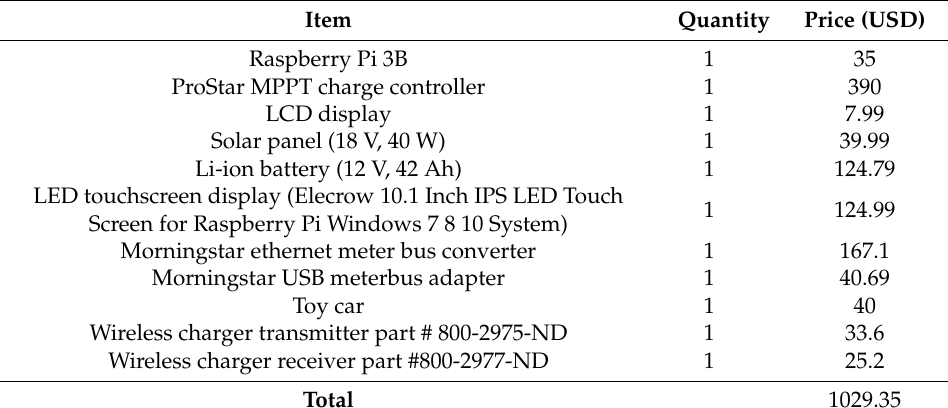
Figure 3. Hardware Schematics. Table 1. List of Materials and